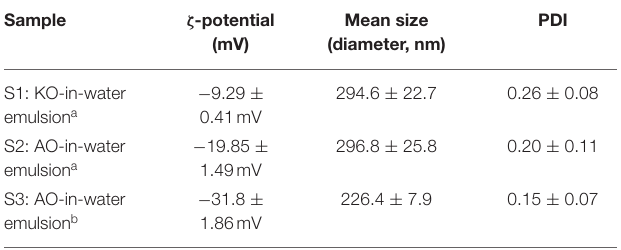
TABLE 2 | Size characteristics and zeta potential values for KO-in-water and AO-in-water emulsions stabilized by using either sodium caseinate from bovine milk or citrem.